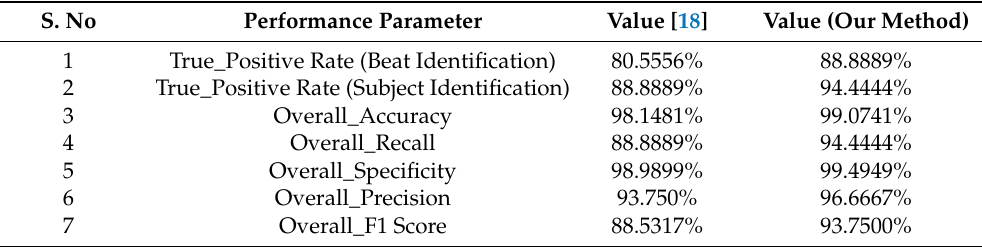
Table 8. Comparison of our method with seven beats and literature [18].